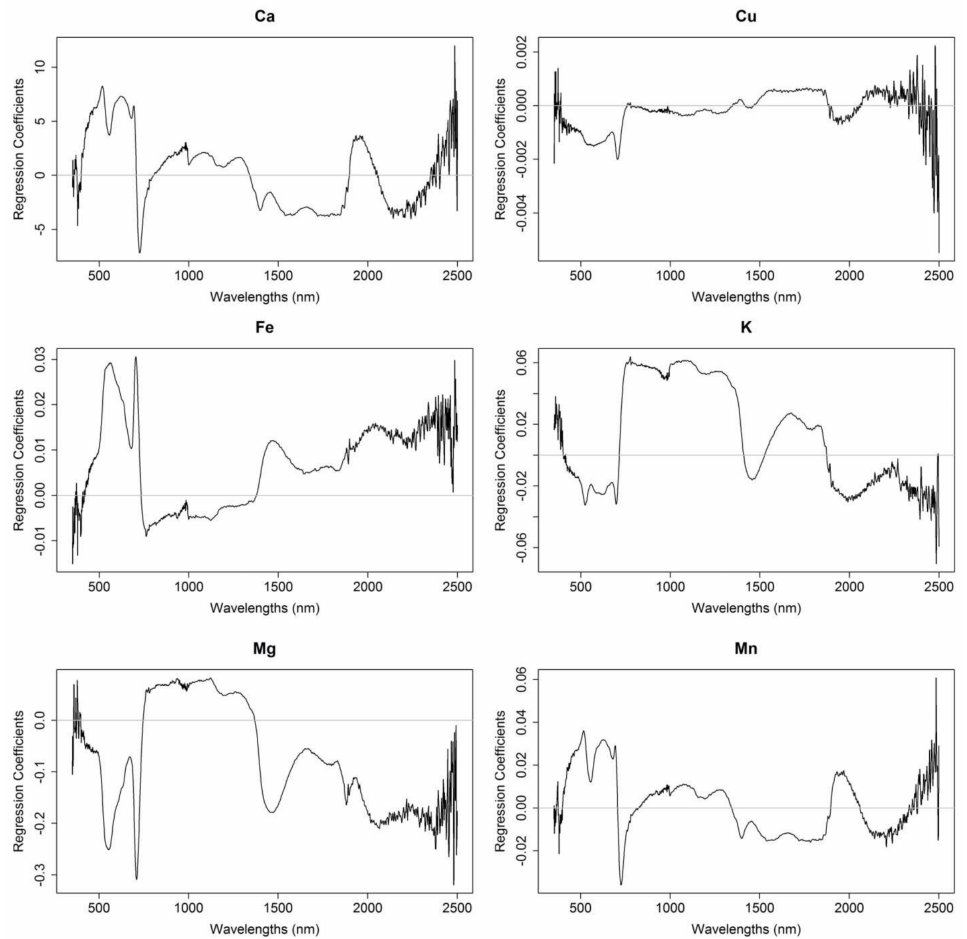
Figure 9. PSLR-coefficients for leaf nutrient concentration